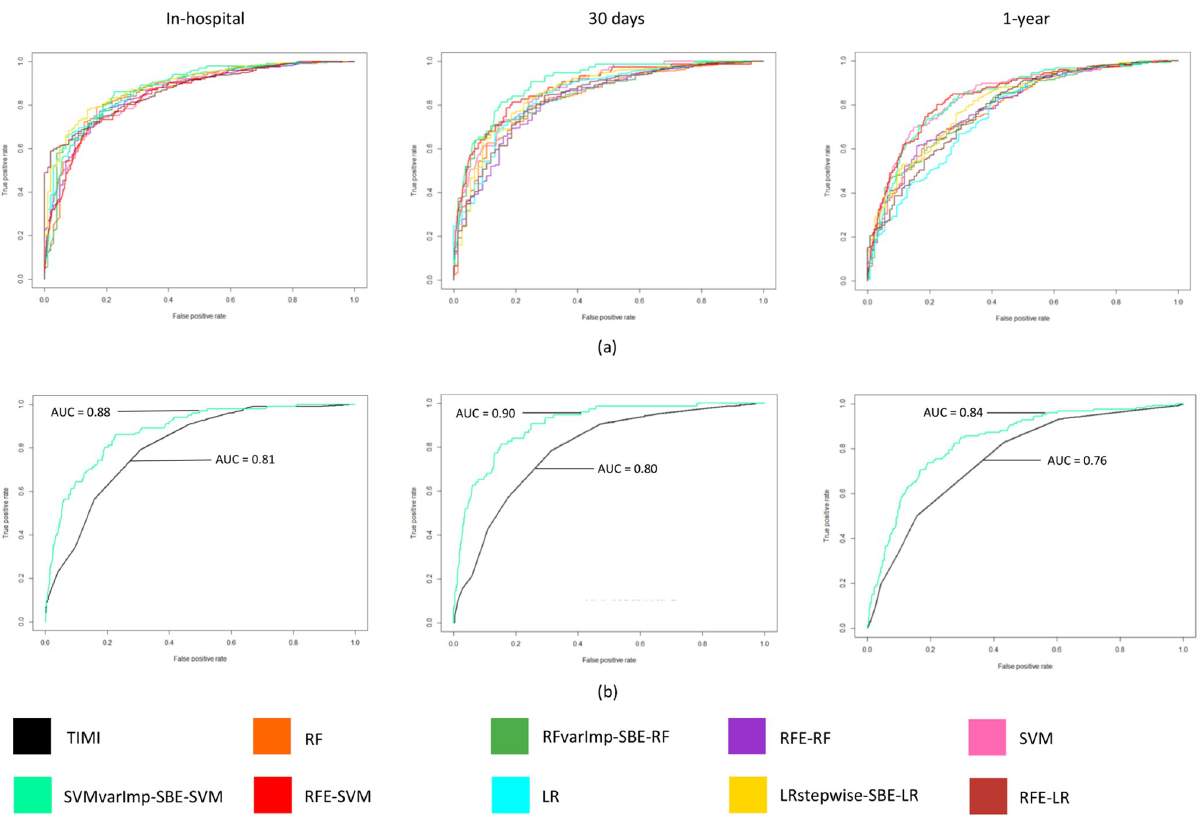
Fig 1. The receiver operating characteristics (ROC) curves of ML models and TIMI score based on a 30% validation dataset. ROC curves show the performance for In-hospital, 30 days and 1-year ML mortality prediction models (a). The ROC values for TIMI against the best ML model (SVMvarImp-SBS-SVM). Abbreviations: varImp = variable importance.